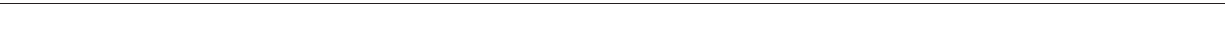
Fig. 2 Spindle matrix proteins regulate NSC reactivation and function downstream of insulin pathway during NSC reactivation. a NSC MARCM clones in control and Mtor k03905 were labelled with Mira, CD8 and Topro-3 (for DNA). b EdU, CD8 and Dpn were labelled in control and Mtor k03905 NSC clones. c Mira and Topro-3 or Dpn and EdU were labeled in NSCs from control and east RNAi knockdown. d , e Dpn and EdU or Mira were labelled in the VNC of control and east RNAi knockdown. f Larval brains from overexpression of an active form of InR (OE InRCA) with UAS-CD8-GFP, overexpression of InRCA with chro RNAi knockdown (OE InRCA + chro RNAi), overexpression of RHEB (OE RHEB) with UAS-CD8-GFP, and overexpression of RHEB with chro RNAi knockdown (OE RHEB + chro RNAi) were raised on sucrose-only (amino-acid free) food for 72 h and labelled by EdU. g Quanti fi cation of EdU + cells per brain hemisphere in various genotypes. h Mira and Dpn were labelled in OE InRCA with UAS-CD8-GFP, OE InRCA with chro RNAi, OE RHEB with UAS- CD8-GFP and OE RHEB with chro RNAi on sucrose-only food. The right panels are enlarged views of the yellow boxes in the left panels. i Quanti fi cation of NSCs with a cellular extension in various genotypes. j Larval brains from OE InRCA with UAS-CD8-GFP and OE InRCA + chro RNAi were raised on sucrose- only food for 24 h and labelled by EdU. k Quanti fi cation of EdU + cells per brain hemisphere for j . l Larval brains from PI3K (PI3K CAAX ) overexpression with UAS-CD8 or chro RNAi knockdown were raised on sucrose-only food for 72 h and labelled by EdU. All error bars indicate ± SD in g , i and k . *** indicates P < 0.001 in g , i and k by Student ’ s t -test. NSC clones were outlined by white dotted lines in a and b . Larval brain hemispheres were outlined by white dotted lines in f , h , j , l . Arrows indicated NSCs in b and arrowheads indicated the cellular extension of NSCs in a , c , e and h . Scale bars: 10 µ m ( a – c , f , h , j , l ) and 20 µ m ( d , e